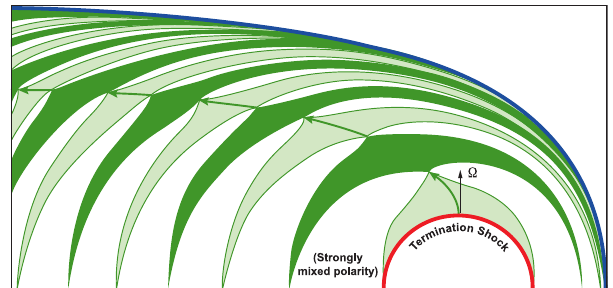
Fig. 2. A schematic meridional view of the sectored heliospheric magnetic field arising from the 11-yr solar cycle polarity reversals. The subsonic solar wind pushes the sectors across the termination shock along the heliotail, compressing them to each other and to- ward the heliopause. The turbulence that is expected to perturb the heliospheric magnetized plasma, determines the thickness of the current sheet outflow regions. While their length depends on the average magnetic field geometry and by the turbulence level. Adapted from Nerney et al. (1995); Lazarian and Opher (2009).